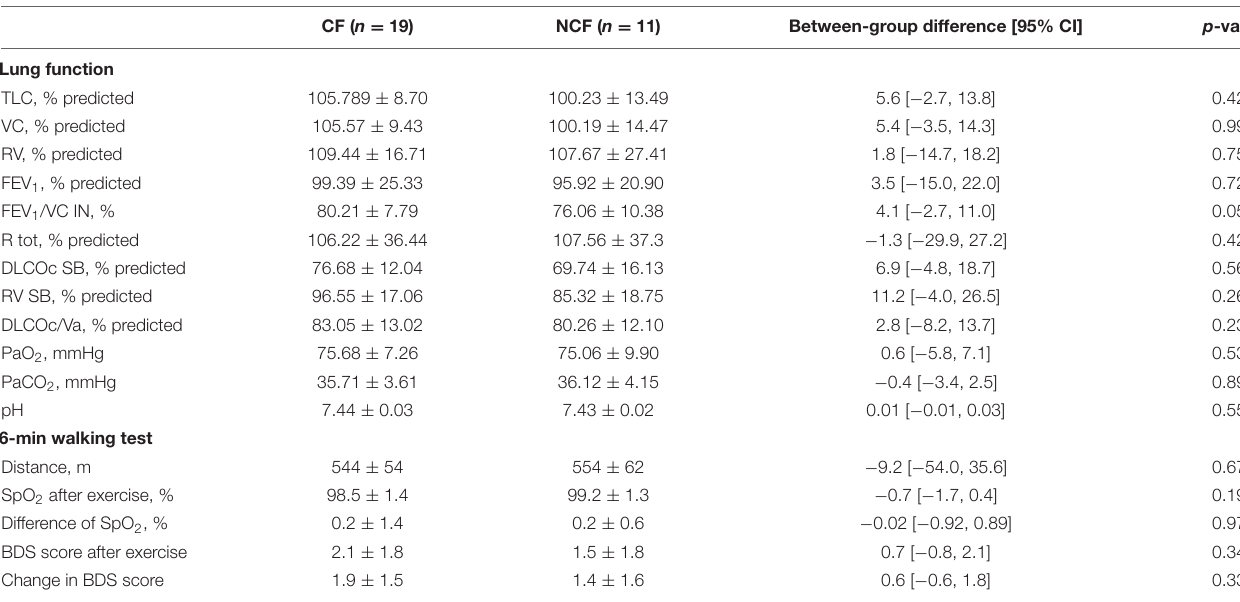
TABLE 2 | Lung function parameters and 6-min walking test